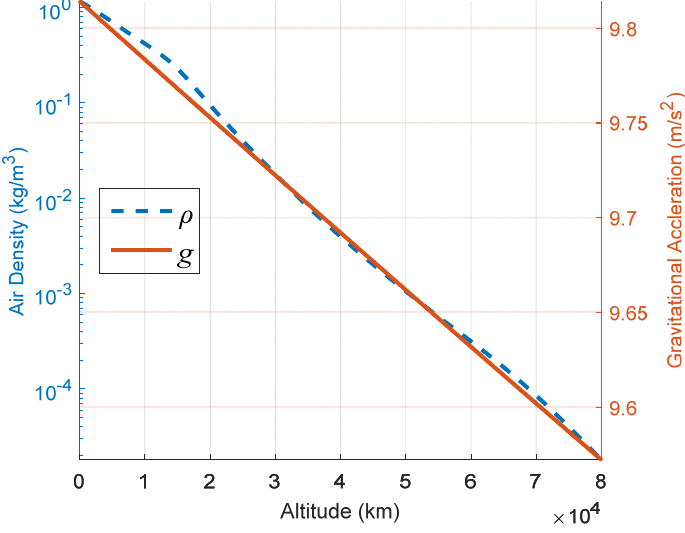
Figure 10. Variations in the air density and gravitational acceleration with the altitude.